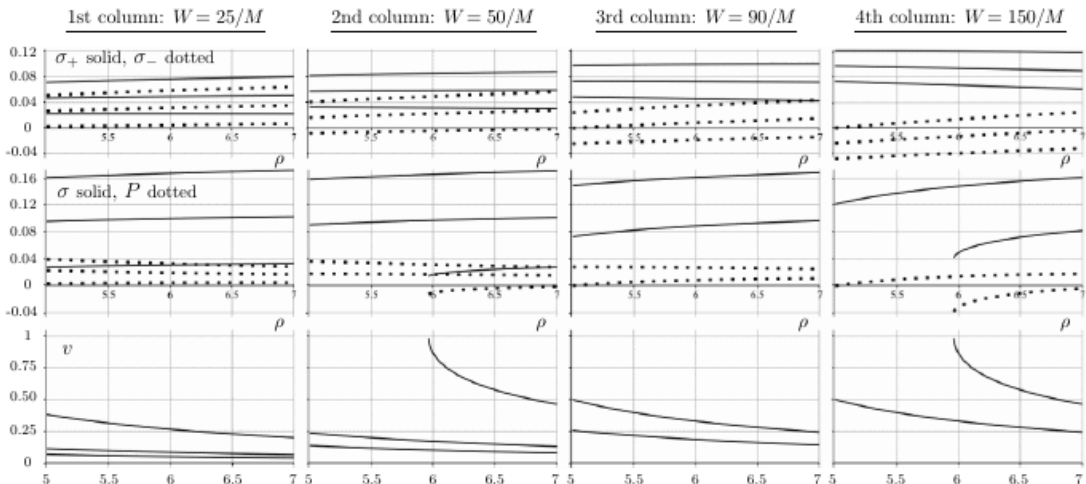
Figure 2. Parameters of the double-stream and single-stream interpretations of the disc, plotted as functions of the Weyl radius ρ for a disc lying between ρ = 5 M and ρ = 7 M , for several combinations of the parameters S (Newtonian mass density) and W (scaling the disc rotation). The first/second/third/ fourth columns represent the cases given by W = 25/50/90/150, with the first row showing densities σ + (solid line), σ − (dotted line) of the double-stream, counter-rotating dust interpretation, the second row showing density σ (solid line) and azimuthal pressure P (dotted line) of the single-stream fluid interpretation, and the third row showing the corresponding “bulk” velocity of the fluid v (solid). For each of the W values, three different values of S have been chosen, S = 0.04, 0.12 and 0.2. The density and pressure curves obtained for higher S are higher (given by larger values), whereas the corresponding bulk velocities decrease with growing S . The chosen values of W and S are well out of the scope of the linear perturbation, but this is in order to illustrate clearly what they represent. Since all the parameters (densities, pressure, velocity) should be real and positive, and the velocity v has to be < 1 in addition, one sees immediately that (i) the discs with a given mass (thus ρ in , ρ out and S ) cannot bear however large angular momentum (with growing W , the density σ − of the double-stream interpretation—and consequently also the single-stream parameters—tend to turn negative); and, (ii) since large W implies the need for high orbital velocities, for too large W the orbital interpretation would have to involve superluminal motion (in the bottom row, from left to right, one sees that all three/two/two/one of the shown cases are “physical” in this respect). The densities S , W , σ + , σ − , σ as well as the pressure P have the dimension of 1/length and their values are in the units of 1/ M , the speed v is dimensionless. Reprinted from [5] by courtesy of the MNRAS